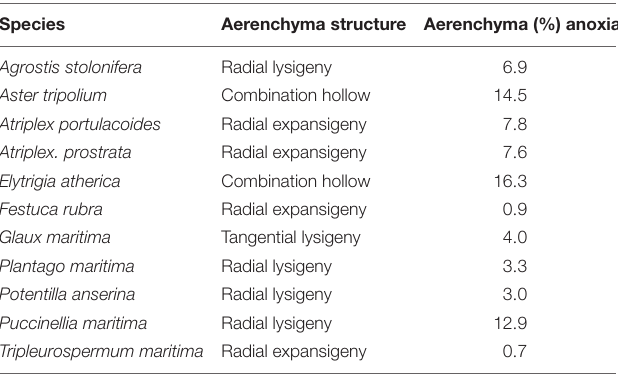
TABLE 3 | Structure and mean percentage of aerenchyma of plants that grew under anoxic conditions per species ( n =